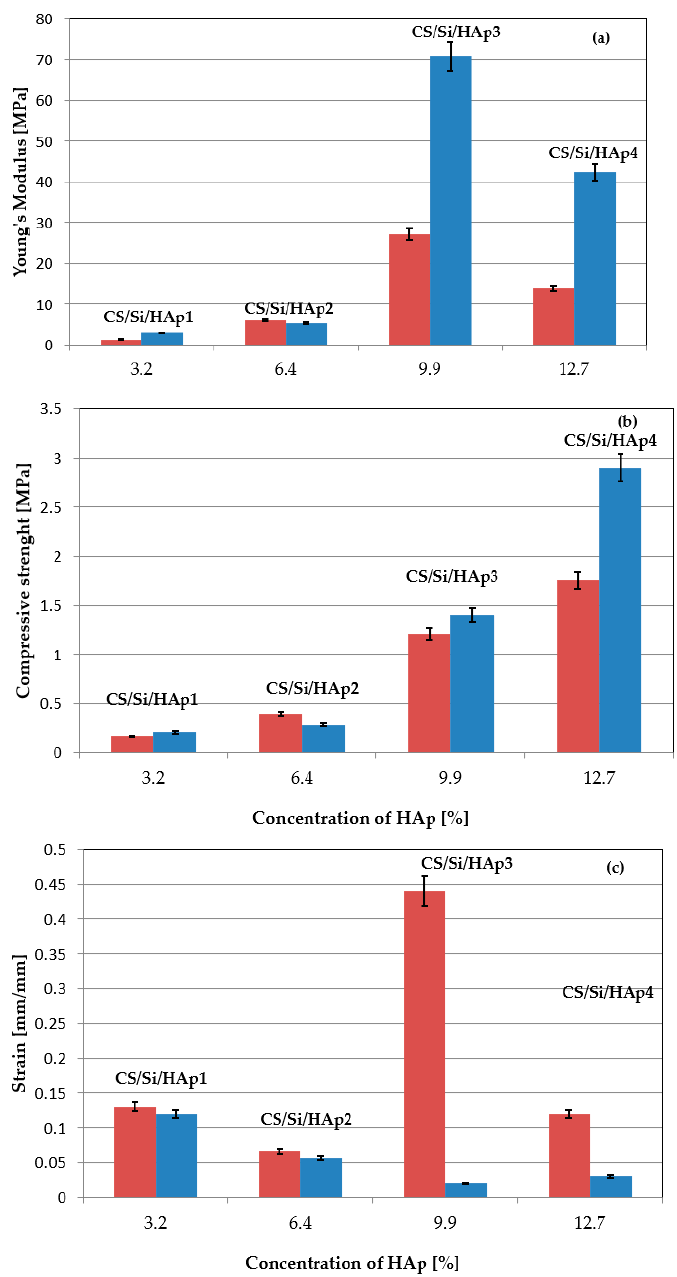
Figure 3. Dependence of Young’s modulus ( a ), compressive strength ( b ), strain ( c ) vs. concentration of hydroxyapatite with 20 wt.% SiO 2 and 0.7–1.1 wt.% chitosan. The drying of samples at a temperature of 100 °C is marked in blue and at 50 °C in red.